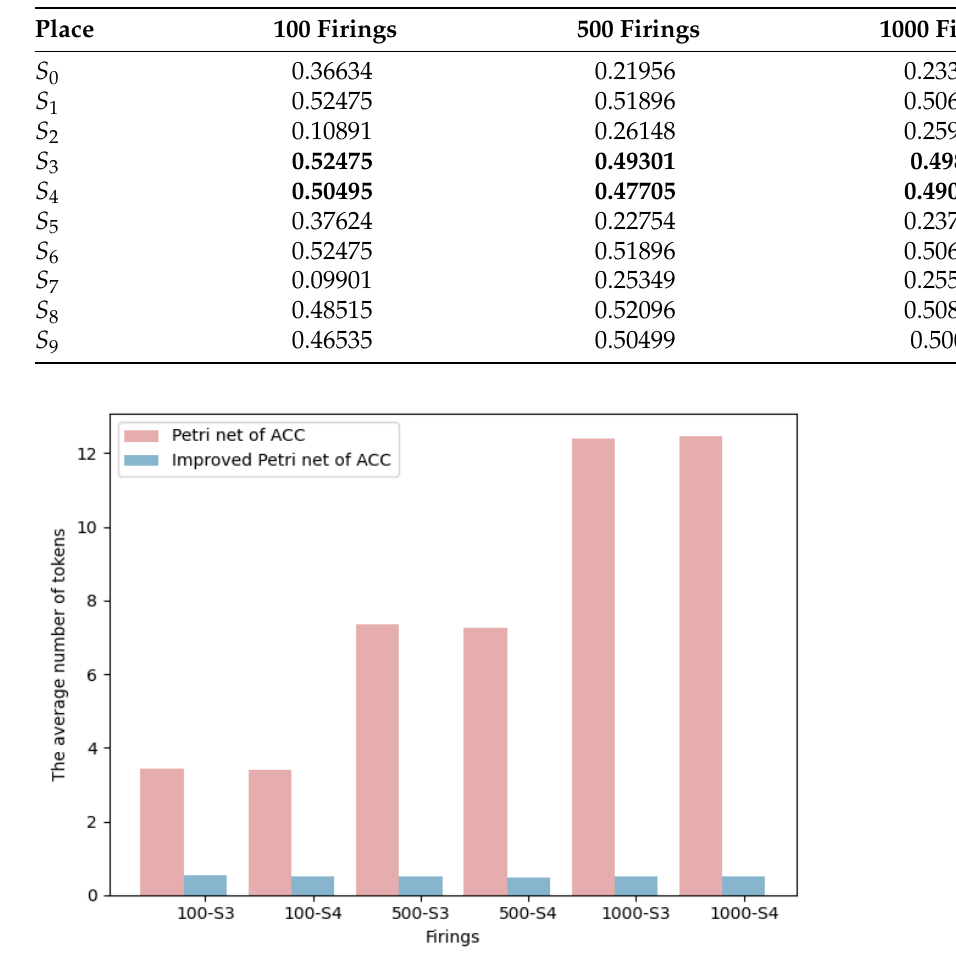
Figure 6. Changes in the average number of tokens in places S 3 and S 4